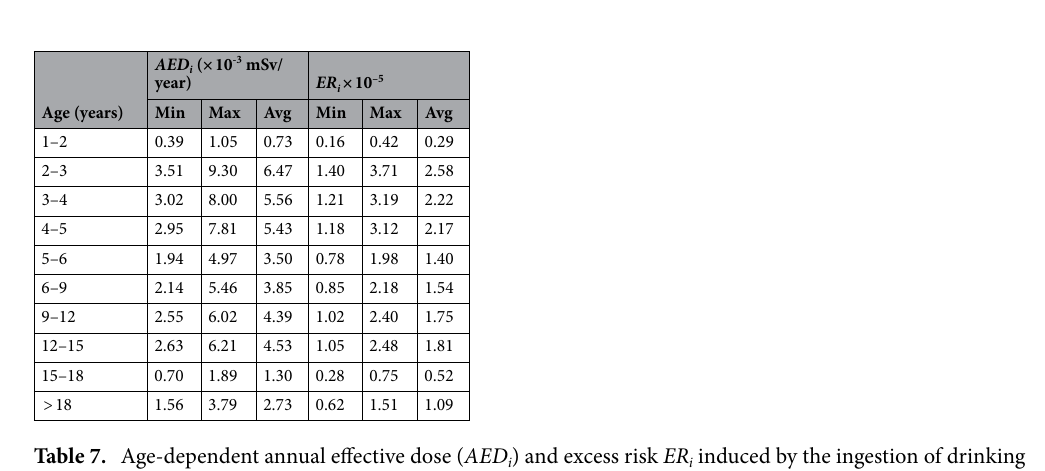
Table 6. Ambient environmental accumulated dose around the Qinshan NPP from 2012 to 2020. a The data shown in the table is the average accumulated ambient radiation doses for all sampling points.